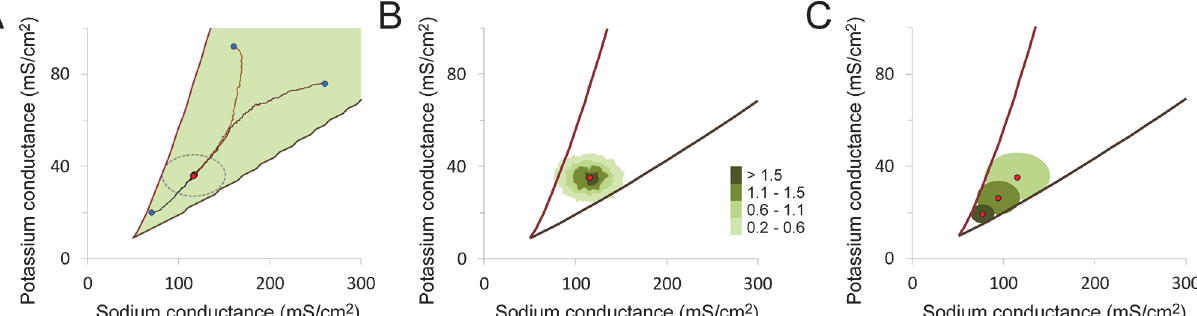
Fig 8. Stability of the end-point for sodium and potassium channel expression from multiple starting points. A. The region of sodium and potassium conductance parameter space that supports action potential conduction at 26°C and Type 3 firing properties (filled green area) bounded by two fitness cliffs (red and brown lines). Three different populations started from a different combination of average sodium and potassium conductance values (blue dots) that converged over successive generations to stable final values (red dots, overlapping symbols). The average final conductance values were G Na = 116.5 ± 0.6 mS/cm 2 and G K = 36.0 ± 0.3 mS/cm 2 (mean ± S.D., n = 3). The colored traces (black, orange and brown) mark the path of the average conductances over 4000 generations for each population, from its starting point to the stable final phenotype. The phenotypic noise used in the simulations had an expected standard deviation of 17.3 mS/cm 2 for the sodium conductance and 4.5 mS/cm 2 for the potassium conductance. These values were previously selected by iteration in order to fit the experimentally observed conductance values. The ellipse (dotted grey line) is centered on the average conductances and the length of the two axes correspond to 4 times the S.D. of the phenotypic noise used in both dimensions. B. The distributions of conductance phenotype for the final population at the end of a representative simulation run. A contour plot of 2D histograms of sodium and potassium conductance combinations shows the final phenotype distribution. Color bar indicates the number of individuals found in each bin, expressed as a percentage of the total population. Bins with fewer individuals than 0.2% of the total population were blanked. The red dot indicates the average conductance values for the population. The variation in channel expression levels within this population reflects a combination of variation in the sodium and potassium channel cis-regulatory genotype as well as the contribution of phenotypic noise. It is this distribution of channel protein expression values, which varies slightly with each successive generation, that is subject to selection. C. Average conductance values for the population increase as the population variation increases. Three simulations are shown. The three different final average conductance values (red dots) are shown with their corresponding population variation (solid ellipses, distinguished as three different shades of green). The changes in population variation were driven by changing the phenotypic noise values. Final conductance values for the three representative individual populations were: G Na = 77.5 ± 6.1, 94.3 ± 11.7, 115.6 ± 18.0 mS/cm 2 and G K = 19.3 ± 2.0, 26.4 ± 3.5 and 35.7 ± 5.1 mS/cm 2 respectively (mean ± S.D., N = 5000). The filled ellipses are centered on the average conductances and the length of the two axes correspond to 4 times the S.D. for that